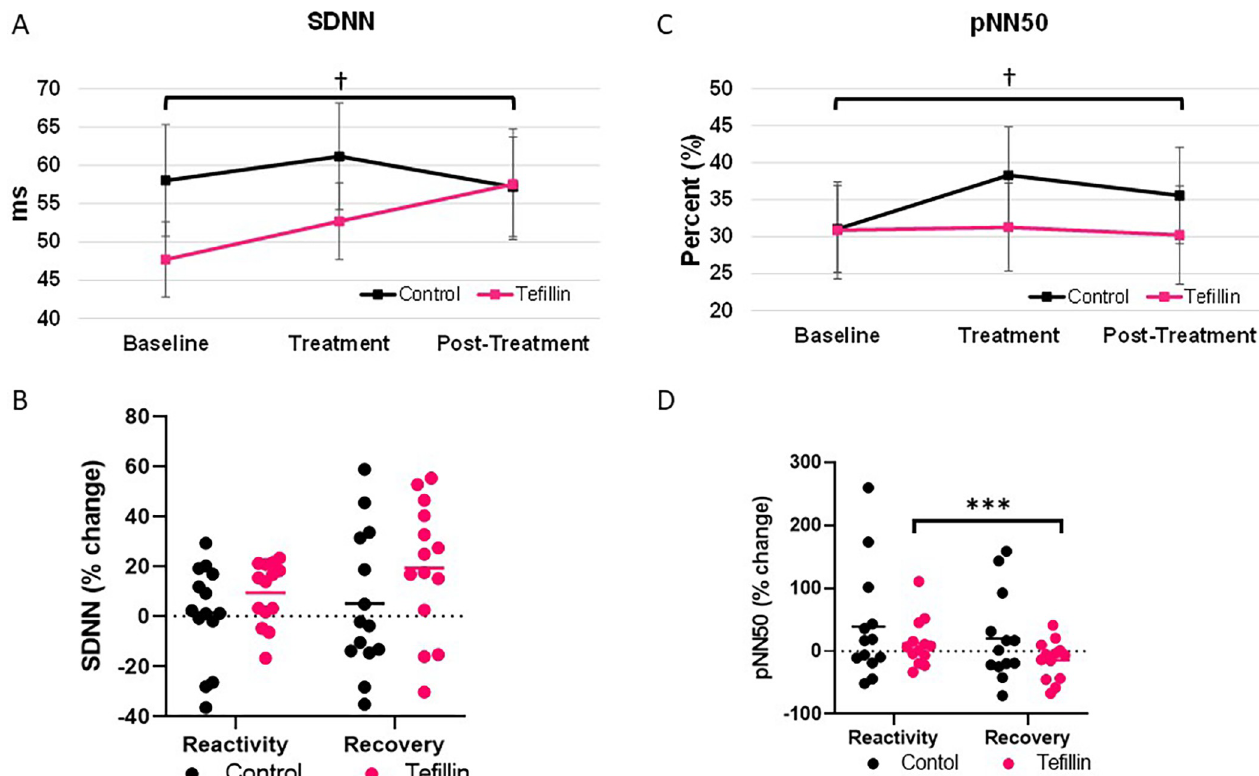
Fig 2. The Time domain measurements were determined for control and tefillin subjects. Standard deviation of all R-R intervals (SDNN) for A . absolute values and B . percent change. Percentage of successive normal sinus RR intervals (pNN50) for C . absolute values and D . percent change. Absolute data represents an average of subjects during baseline, treatment and post-treatment ± SEM. Reactivity and recovery are the average differences between the baseline and treatment as well as treatment and post-treatment ± SEM, respectively. †P < 0.05 compared to baseline and ��� P = 0.027 for tefillin reactivity compared to tefillin